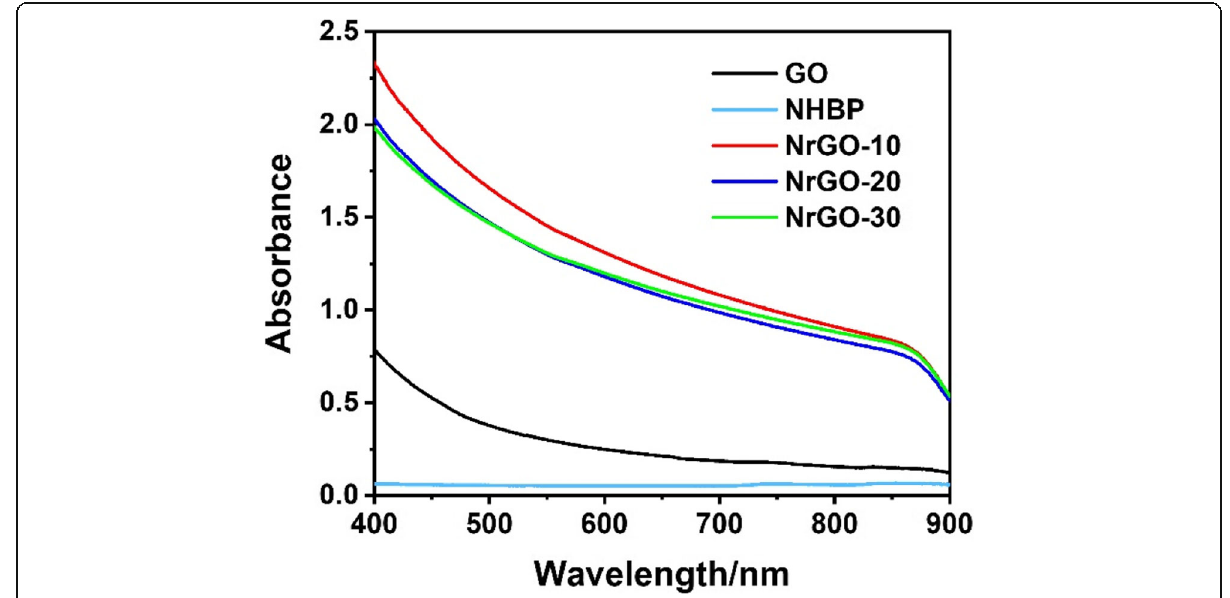
Fig. 5 UV-vis-NIR spectra of GO, HBP, and NrGO samples